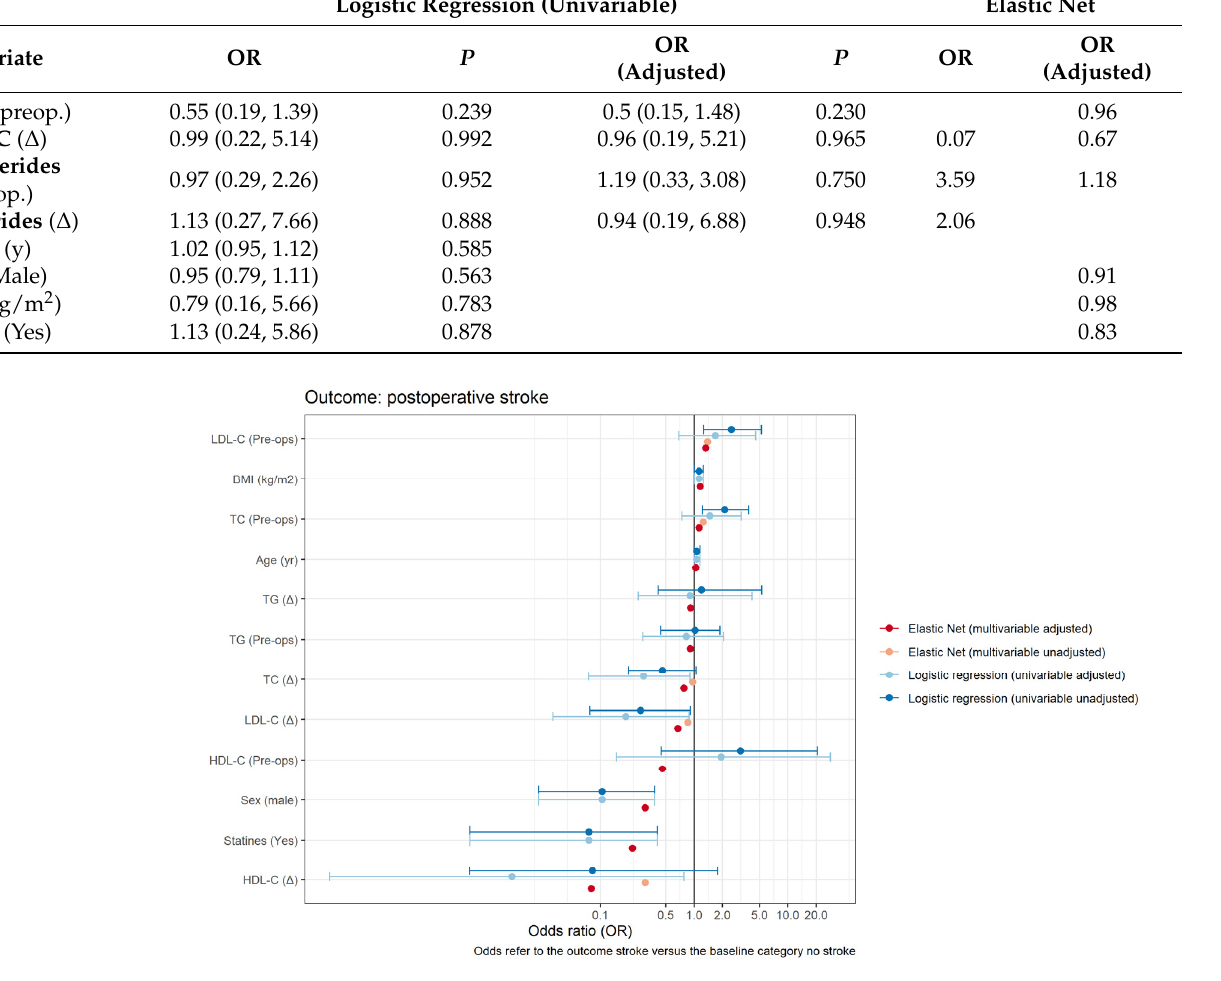
Figure 4. Forest plot showing the estimates of the odds ratio of various predictors on the outcome postoperative stroke. For the logistic regression models, 95% confidence intervals are shown as well (adjusted values). No formal confidence intervals are computed for the elastic net regressions. Table 5. Association between individual lipids (in units (mmol/L)) and the outcome survival after one year follow ‐ up. Preoperative values as well as their change during the operation (postoperative minus preoperative) are presented. The left part of the table shows odds ratios (OR) and their 95% confidence intervals for the case of univariable regressions both for the crude association and ad ‐ justed for the confounders age, sex, BMI, and statins. The right part shows the OR computed by an elastic net logistic regression to account for the correlation across the lipids. An OR > 1 refers to increased risk, and OR < 1 refers to a protective effect with respect to a unit change in a particular characteristic.